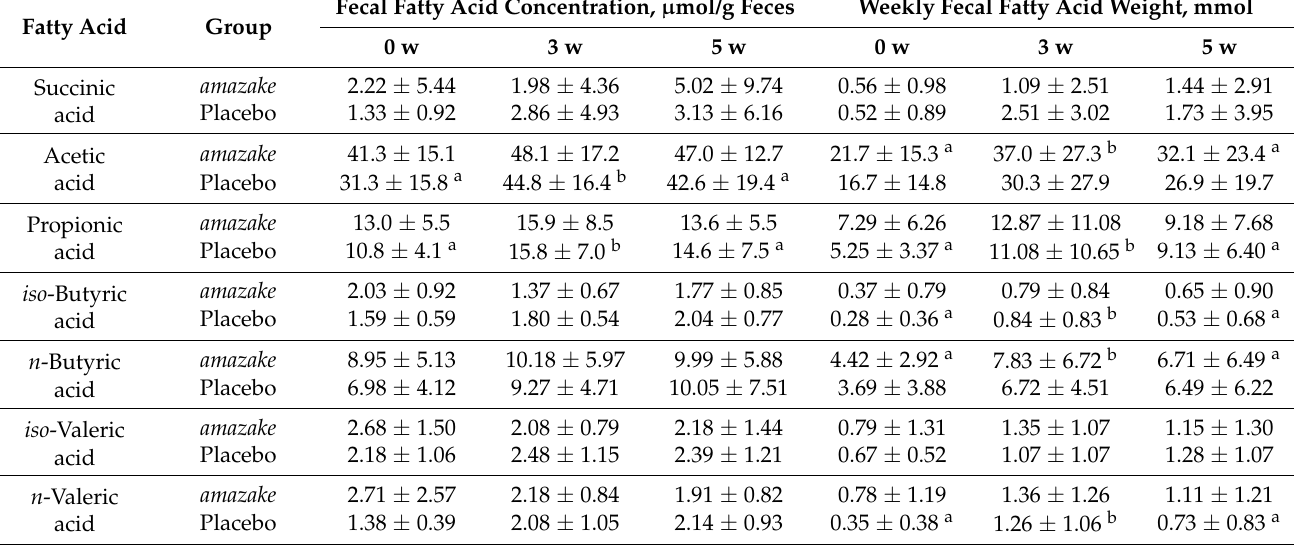
Table 3. Fecal fatty acid concentrations and weekly fecal fatty acid weights of koji amazake and placebo groups on the last day of non-intake observation, intake, and follow up periods. (1,2)